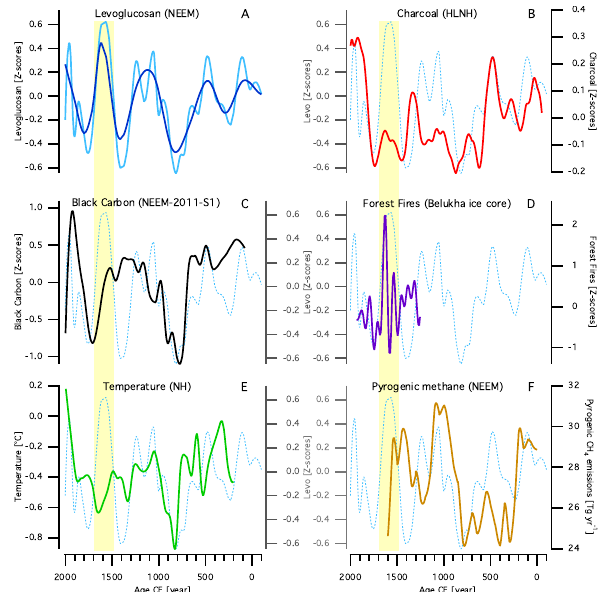
Figure 3. (a) LOWESS with SPAN parameter ( f ) 0.1 (light blue) and 0.2 (dark blue) of levoglucosan Z scores without peaks above the threshold 3rd_Q + 1.5 × IR; (b) high-latitude (above 55 ◦ N) Northern Hemisphere (HLNH) Z scores of charcoal influx (200- year LOWESS) as reported in Marlon et al. (2008) (red) and smoothed levoglucosan with f = 0 . 1 as in (a) (dashed line); (c) LOWESS with f = 0 . 1 of black carbon Z scores without peaks above the threshold 3rd_Q + 1.5 × IR (black) and smoothed levo- glucosan (dashed line); (d) Siberian forest fire reconstruction (Eich- ler et al., 2011) (purple) and smoothed levoglucosan (dashed line); (e) LOWESS with f = 0 . 1 of Northern Hemisphere land tem- perature (Mann et al., 2008) and smoothed levoglucosan (dashed line); (f) pyrogenic CH 4 emissions inferred from the deep NEEM core (Sapart et al., 2012) (light brown) and smoothed levoglucosan (dashed line). The yellow vertical bar indicates the period of strongest fire